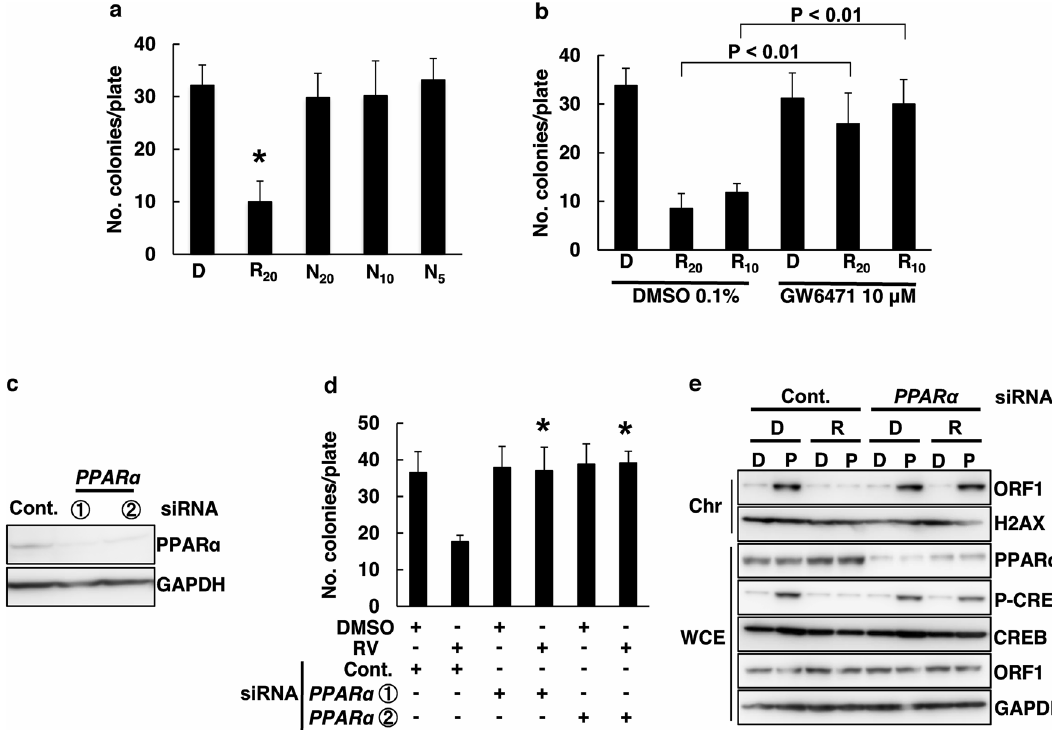
Figure 5. PPARα is involved in inhibitory effects of RV. ( a ) Inhibitory effects of RV inhibited on L1-RTP are independent of antioxidant effect. HeLa cells were incubated for 2 days with 20 μM RV or 5, 10, 20 mM NAC. DMSO (0.02%) control (D), 20 μM RV (R 20 ), 20 mM NAC (N 20 ), 10 mM NAC (N 10 ), and 5 mM NAC (N 5 ). Colony numbers are presented as the mean ± SD. (* p < 0.01). ( b ) Effect of a PPARα antagonist on the inhibitory effects of RV. HeLa cells treated with 10 μM RW6471 or 0.1% DMSO: D for 1 h before treatment with 20 μM RV: R 20 or 10 μM RV: R 10 . ( c ) Effects of PPARα siRNA on the expression of the endogenous PPARα protein. Expression level of PPARα protein was examined in HeLa cells that had been transfected with pL1-Neo R and PPARα siRNA. Cont., control siRNA (10 nM); ① and ② , PPARα siRNA-1 or siRNA-2 (10 nM), respectively. ( d ) PPARα was required to inhibit L1-RTP by RV. A colony formation assay was performed for HeLa cells after introducing either control siRNA or PPARα siRNA-1 or siRNA-2. The cells were treated with 0.02% DMSO (D) or 20 μM RV (R) for 2 days. The mean numbers of colonies ± SD are shown. The effects of PPARα siRNAs were significant (* p < 0.01). ( e ) Inhibition of chromatin recruitment of ORF1 by RV depends on PPARα . Experiments were done according to a depicted protocol by Fig. 3 D. DMSO (D) of 0.02% or 20 μM RV (R). DMSO (0.02%; D), 18 μM PhIP